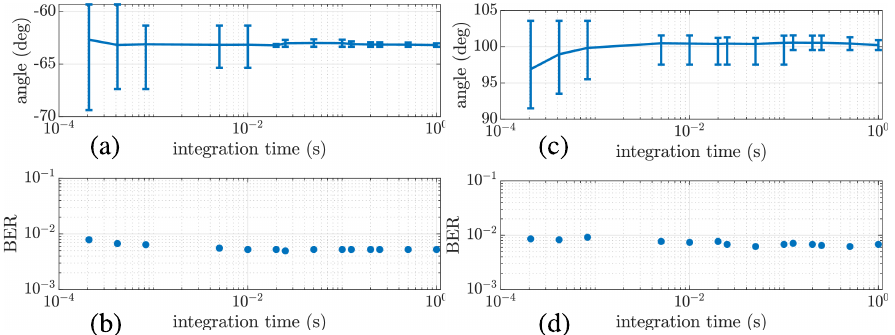
Figure 9. Estimated angle and BER varying the integration time for stations 2 ( a , b ) and 7 ( c , d ),